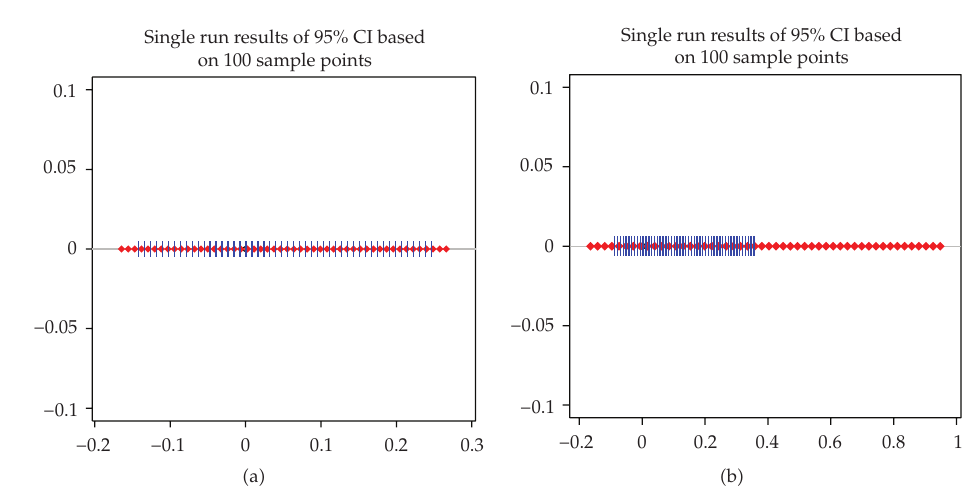
Figure 1: 95% confidence intervals by t (cid:2) red one (cid:3) and new procedures (cid:2) blue one (cid:3) for the mean of F based on 100 sample points from F : (cid:2) a (cid:3) F (cid:4) N (cid:2) 0 , 1 (cid:3) and (cid:2) b (cid:3) F (cid:4) t (cid:2) 3 (cid:3)